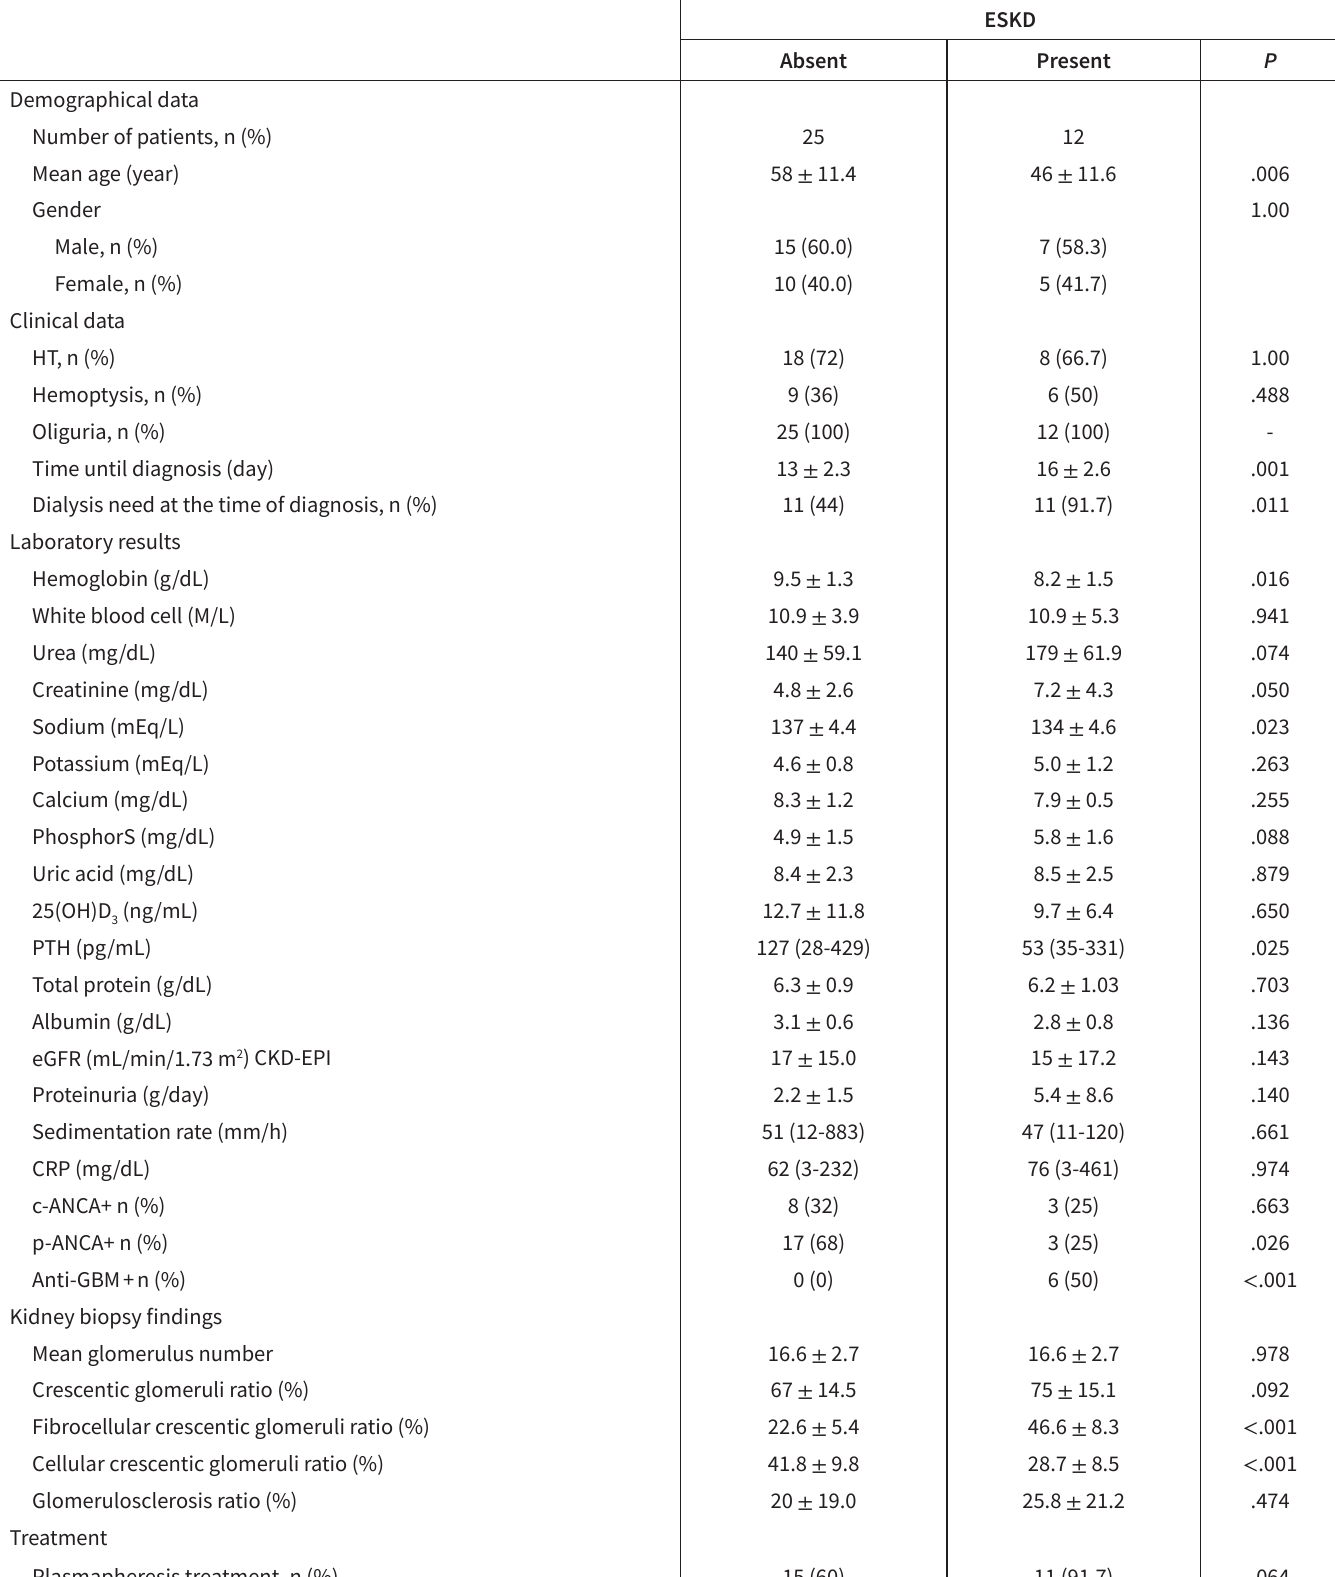
ESKD Absent Present P